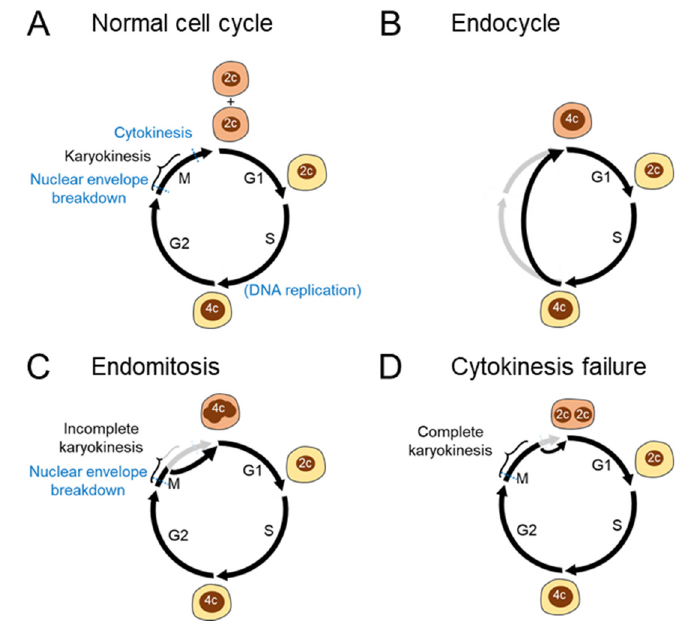
Figure 2. Cell cycle aberrations leading to polyploidization ( A ) Normal cell cycle. A diploid cell gives rise to two diploid daughter cells through mitosis. ( B ) Endocycle. The S and G1 phases are repeated without entering the M phase, leading to the emergence of mononuclear polyploid cells. ( C ) Endomitosis. Although cells enter the M phase with chromosome condensation and disruption of the nuclear envelope, the mitotic process is aborted, leading to the genesis of mononucleated polyploid cells. ( D ) Cytokinesis failure. Cells complete karyokinesis but not the following cytokinesis, generating binucleated polyploid cells. 2c and 4c denote diploid and tetraploid DNA contents, respectively.